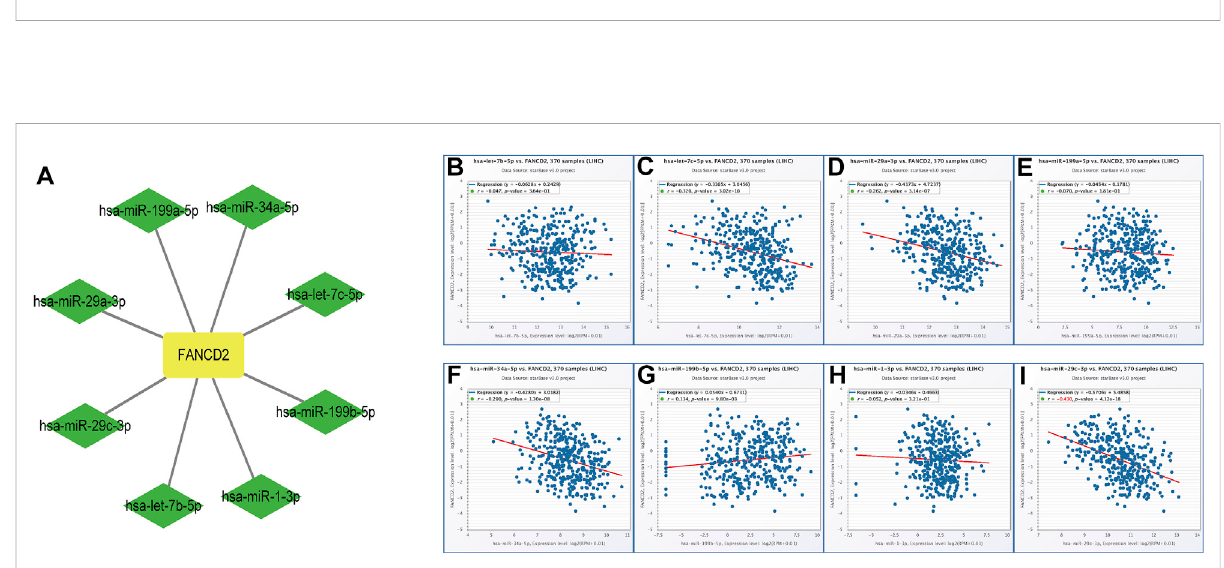
FIGURE 5 Identi fi cation of the miRNA-FANCD2 regulatory network in HCC. (A) FANCD2-associated miRNA network was visualized using Cytoscape. (B – I) Expression correlation between predicted miRNAs and FANCD2 in HCC analyzed by the starBase